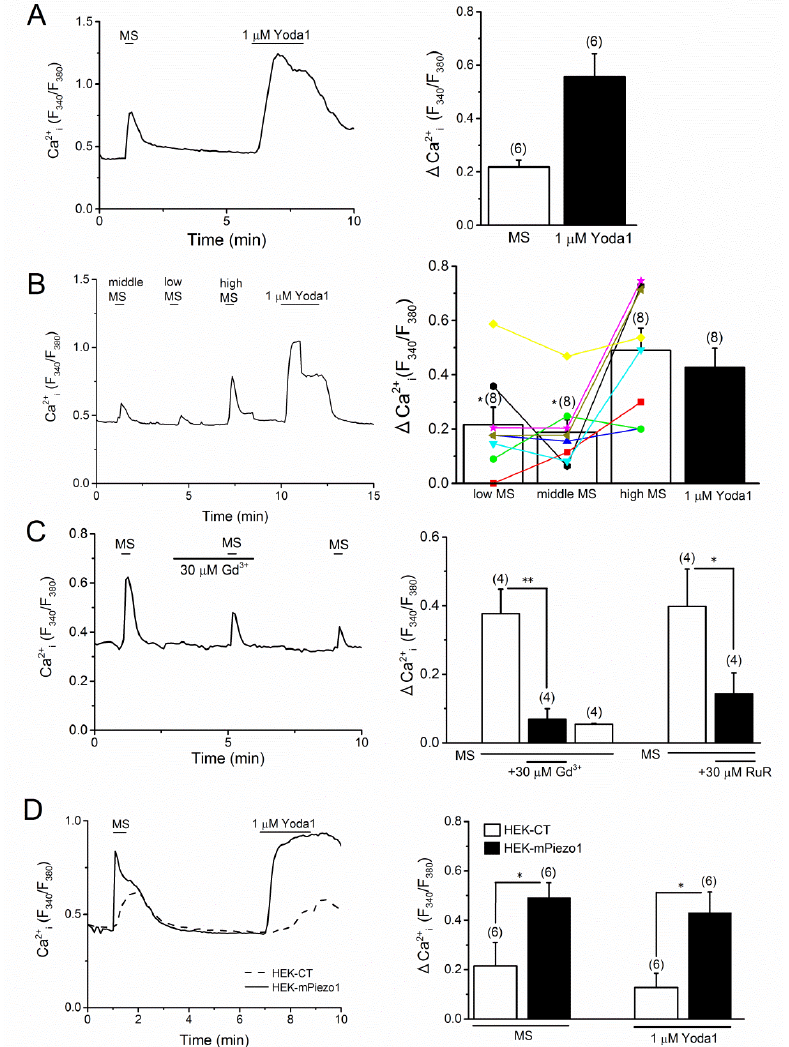
Figure 3. Mechanical stimulation-induced Ca 2+ response in MC3T3-E1 and HEK-mPiezo1 cells. Mechanical stimulation (MS) with shear stress, which was induced by fluid flow, was applied to the cells monitoring Ca 2+ response. ( A ) MC3T3- E1 cells were exposed to MS (7.67 μL/s) and 1 μM Yoda1 (left panel) and the peak change in each Ca 2+ response was summarized as a bar chart (right panel).